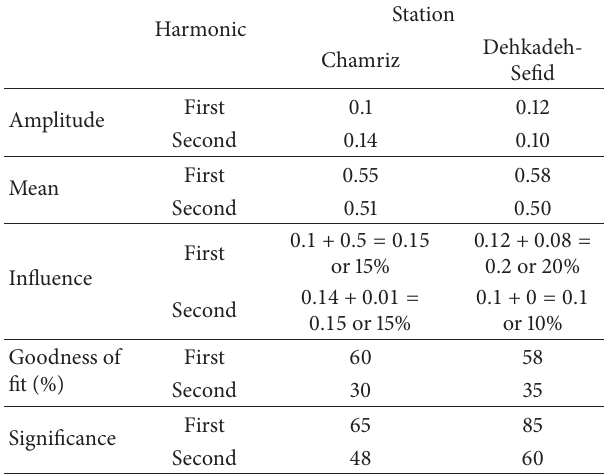
Table 2: Calculated parameters of sine curves at two stations under